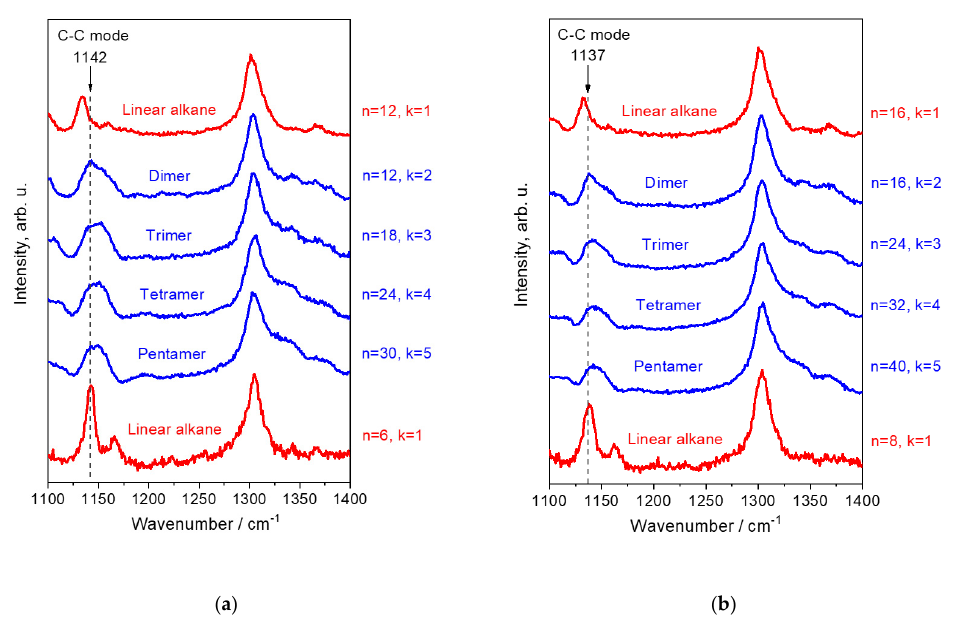
Figure 5. Raman spectra of the hydrogenated 1-hexene ( a ) and 1-octene ( b ) oligomers and linear alkanes with n = 6, 12 ( a ) and n = 8, 16 ( b ) in the region of the symmetric C–C stretching mode. We defined the spectral characteristics (the wavenumbers and the full widths at the half- maximum (FWHM)) of the C–C band in Table 1. The wavenumbers and FWHMs for the dimers were determined by the spectrum deconvolution using two lines and nonlinear (second-order polynomial) background. The profile of each line was described as a weighted sum of Gaussian and Lorentzian functions [25]. For other oligomers, the wavenumber values, obtained using the spectrum deconvolution, demonstrated a poor accuracy (about 5 cm − 1 ). For this reason, the wavenumbers given in Table 1 of the C–C mode for trimers, tetramers, and pentamers were evaluated at intensity maximums of their Raman bands.